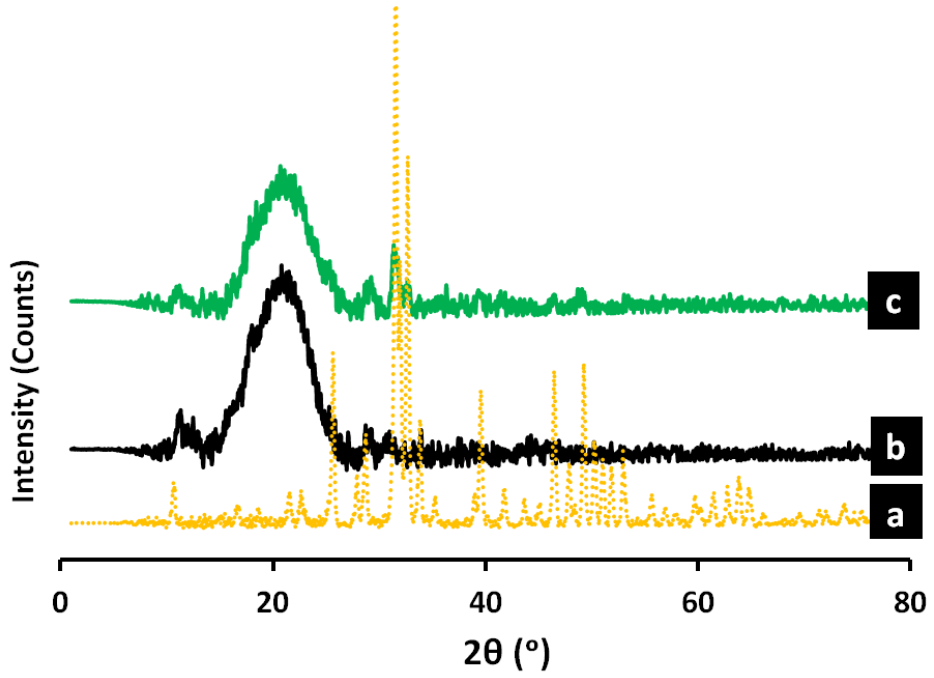
Figure 7. The XRD diffraction pattern of ( a ) Pure nanohydroxyapatite (nHA), ( b ) 25% GA/chi- tosan/0% nHA, and ( c ) 25% GA/chitosan/ 5% nHA composite hydrogels .